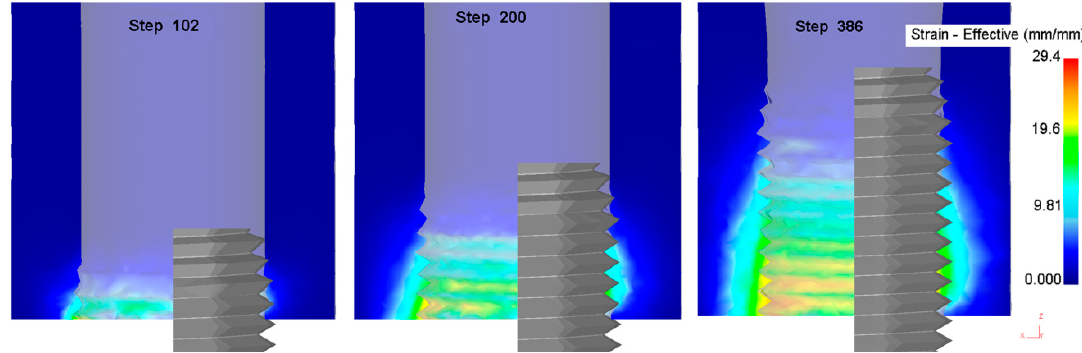
Figure 5. Equivalent strain nephogram of different steps.